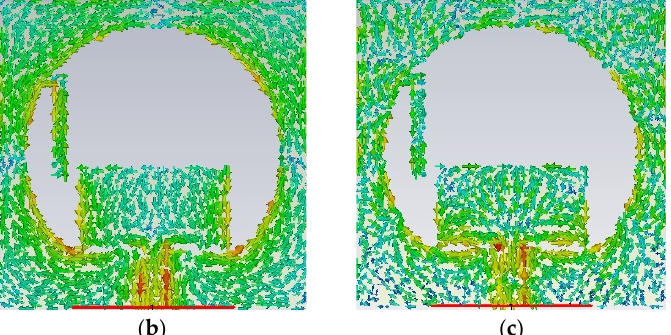
Figure 5. Surface current of the proposed antenna with single-arm ILSS at the operating frequencies of: ( a ) 2.45 GHz, ( b ) 5.5 GHz and ( c ) 15.5 GHz.